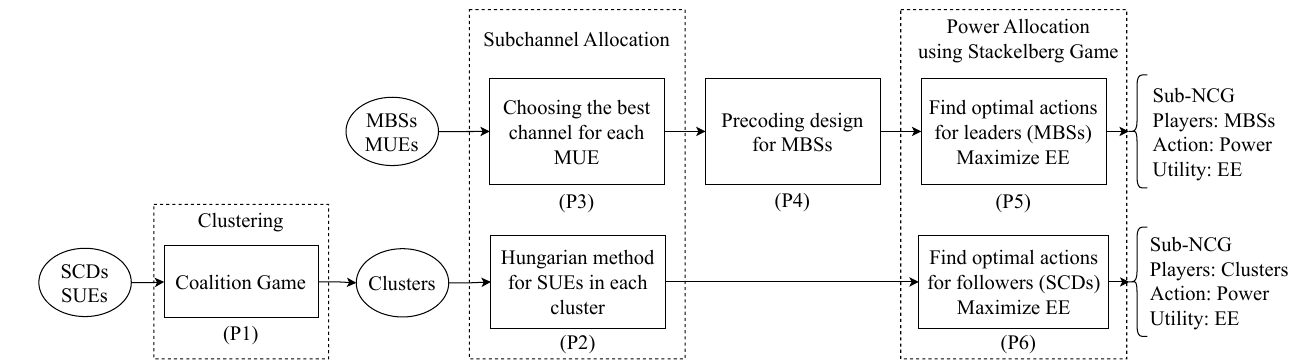
Figure 2. Block processing operations of proposed optimization